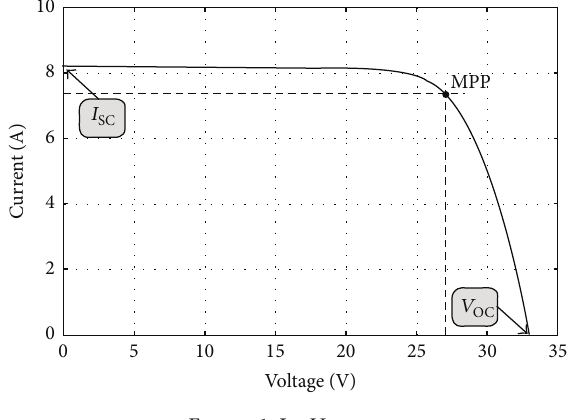
Figure 1: 𝐼 × 𝑉 curve.